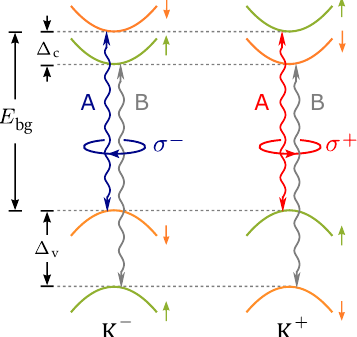
Figure A3. Band structure of WSe 2 monolayer. Green and orange solid curves represent spin-up and spin-down bands in the K ± valleys, respectively. Double-headed wavy arrows represent such spin-allowed optical transitions in each valley. The blue/red arrows indicate the lower-energy (A-exciton) transitions realized in the experiment. The grey arrows represent the B-exciton transitions, which, however, are not activated by the pump pulse used in the experiment. The blue/red color of the corresponding arrows indicates the left/right circular polarization of light, which couples electromagnetically with the corresponding